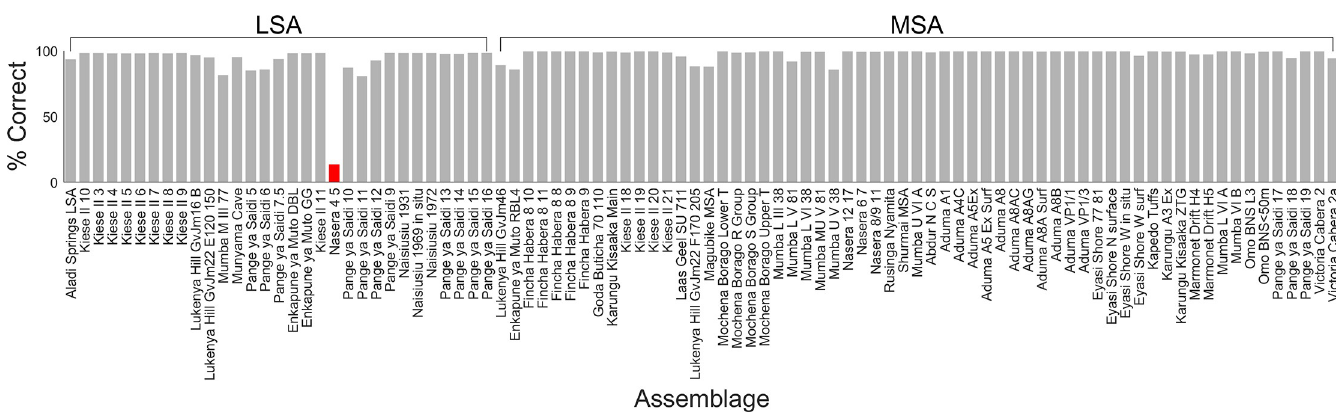
Fig 8. Percentages of correct classification (2-way). Percentages of the 1,000 networks that classify each assemblage correctly in the 2-way analysis. Red bars indicate those assemblages classified incorrectly by a weighted mean over the ensemble of networks.